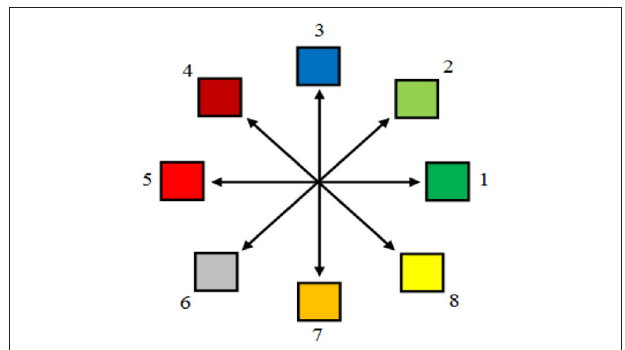
FIGURE 2 | Computation directions of the D8 algorithm (Coulibaly et al., 2016). Directions: 1—east, 2—north-east, 3—north, 4—north-west, 5—west, 6—south-west, 7—south,